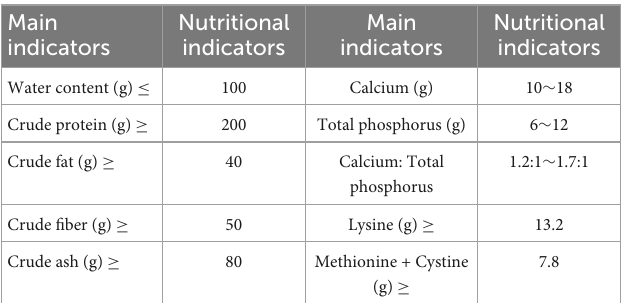
TABLE 1 Guaranteed values of the main indicators of the nutrient composition of Co60 irradiated experimental rat growth and reproduction diets (content per kg of